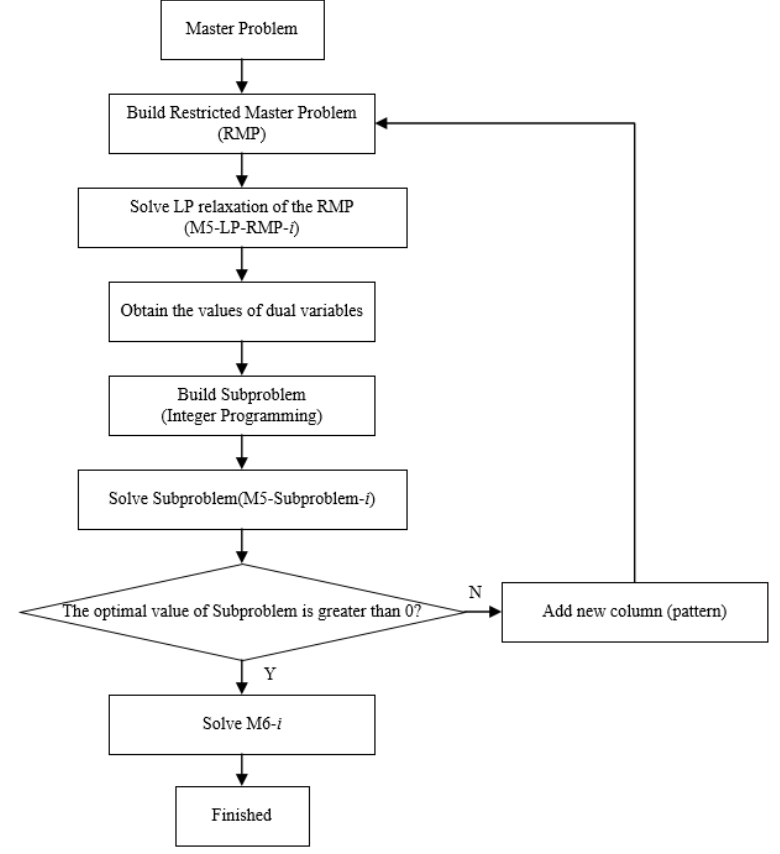
Figure 2. Column generation method.